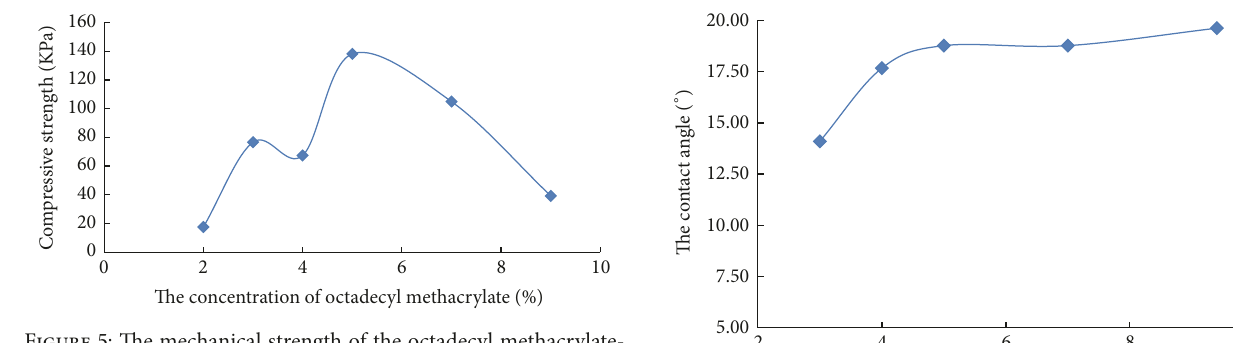
Figure 5: The mechanical strength of the octadecyl methacrylate- acrylamide-N,N 󸀠 -bis(acryloyl)-cystamine hydrogel.